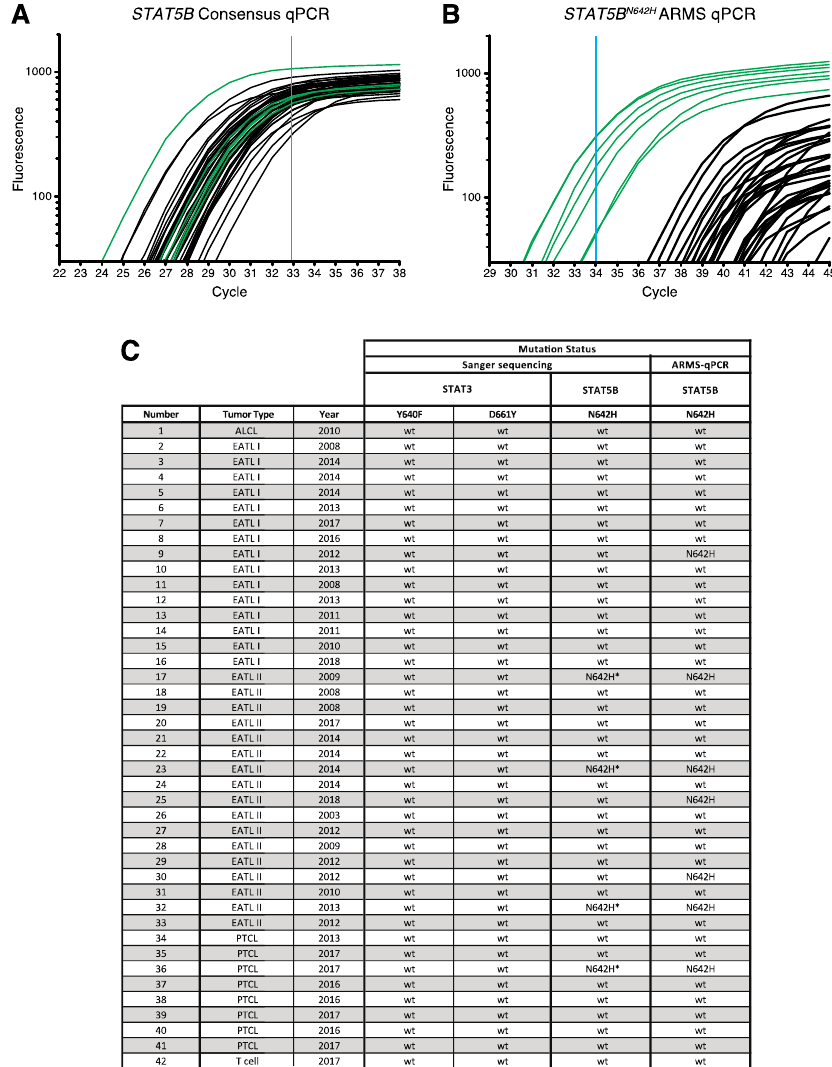
Figure 5. Confirmation of known activating mutations of STAT5B in feline alimentary tumour cells by ARMS-qPCR. ( A , B ) Amplification plot obtained using the wild-type (consensus) primers ( A ) and the STAT5B N642 mutant-specific (ARMS) primers ( B ) in qPCR with genomic DNA of the alimentary lymphoma samples indicated in ( C ). Samples showing a positive signal in the ARMS-qPCR are indicated in green in panels ( A , B ). Fluorescence is presented as fluorescence intensity over background, and ( A , B ) have been corrected for the standard curves in Figure S6. Blue lines indicate the lower limit of the linear dynamic range of the assays. n = 3 each. ( C ) Table showing the samples used in the analysis, their pathological classification and the year of isolation together with the results from Sanger sequencing for Y640 and D661 of STAT3 and for N642 of STAT5 . N642H * indicates a minor peak in the sequencing reaction as shown in Figure 4F, corresponding to N642H. ALCL = anaplastic large cell lymphoma.